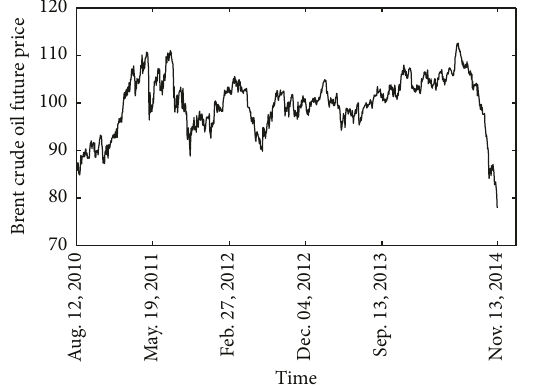
Figure 3: Brent crude oil future prices series.